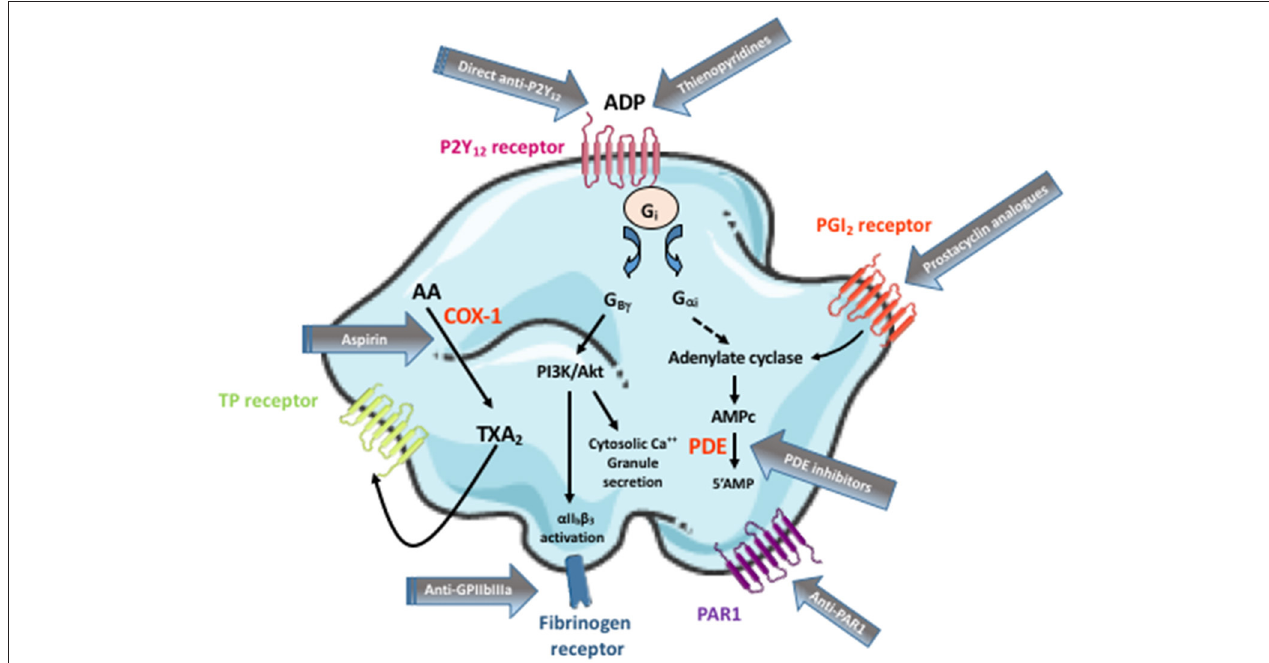
FIGURE 1 | Targets of the commercialized antiplatelet agents. Arachidonic acid (AA) is produced by membrane phospholipids upon the action of phospholipase A 2 . It is metabolized in cyclic endoperoxydes by the cycloxygenase-1 (COX-1) enzyme, then in thromboxane A 2 (TXA 2 ) by the thromboxane synthase. TXA 2 activates the Thromboxane Prostanoid (TP) receptor in return. ADP, by activating P2Y 12 receptor, induces an inhibition of adenylate cyclase which downregulates cAMP (a powerful platelet inhibitor) synthesis. It also stimulates the phosphoinositide 3-kinase (PI3K) via G βγ protein complex resulting in Akt stimulation, which activates a number of downstream substrate proteins thereby increasing the cytosolic Ca 2 + levels and inducing granule secretion. Inversely, prostacyclin (PGI2) binds to its receptor on platelet surface and increases cAMP intraplatelet level. cAMP is metabolized by phosphodiesterases (PDE) in 5’AMP. Blocking ADP binding site with a P2Y 12 receptor antagonist (including thienopyridines and direct anti-P2Y 12 ), stimulating PGI 2 receptor or inhibiting PDE maintains cAMP intraplatelet concentration at a high level thus keeping platelets in a resting state. Following coagulation activation, thrombin is generated and cleaves its receptor on platelet surface, i.e., the protease-activated receptor 1 (PAR1), resulting in its activation. TP, P2Y 12 , or PAR1 activation leads to a conformational change of the glycoprotein (GP)IIbIIIa (also called the integrin α II b β 3 ) on platelet surface which links fibrinogen resulting in platelet aggregation. This figure does not aim to represent platelet physiology with the different signaling pathways. It rather illustrates in a very simple manner the targets of the currently available antiplatelet drugs.